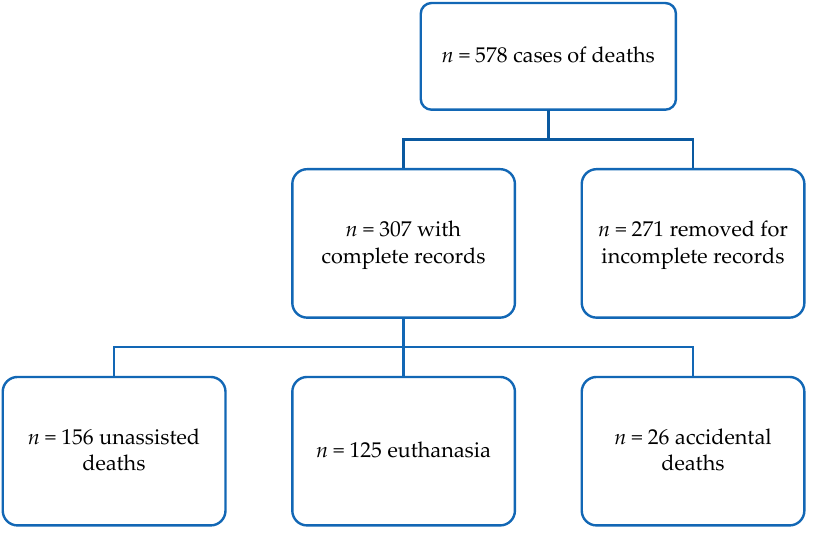
Figure 1. Flow chart showing death methods.